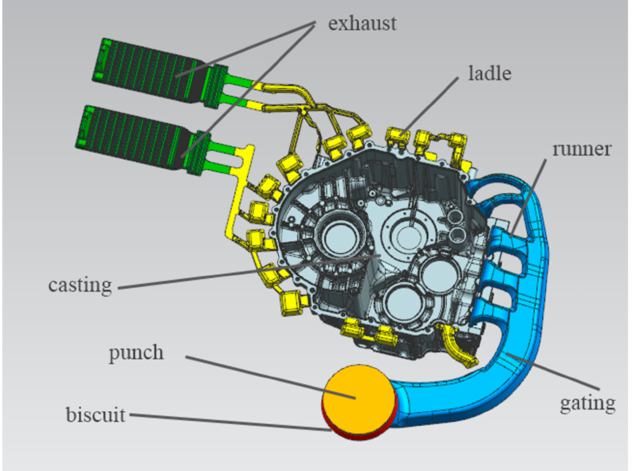
Figure 4. Casting pouring